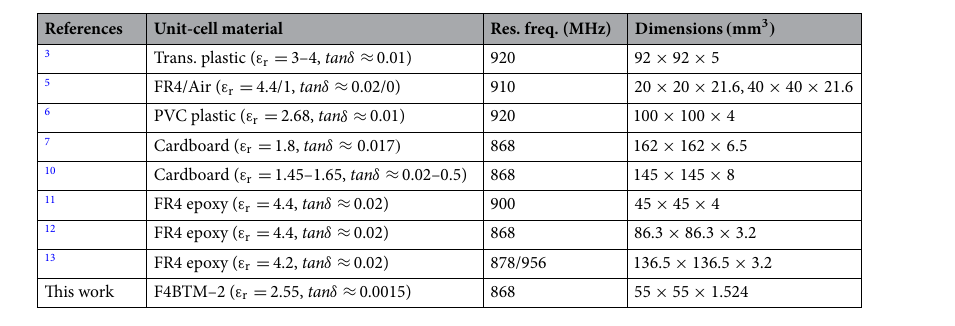
Table 1. Comparison among unit-cells operating around 868